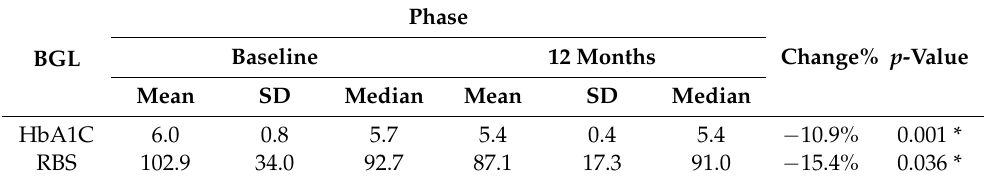
Table 2. HbA1c and RBS changes among study participants before and after laparoscopic sleeve